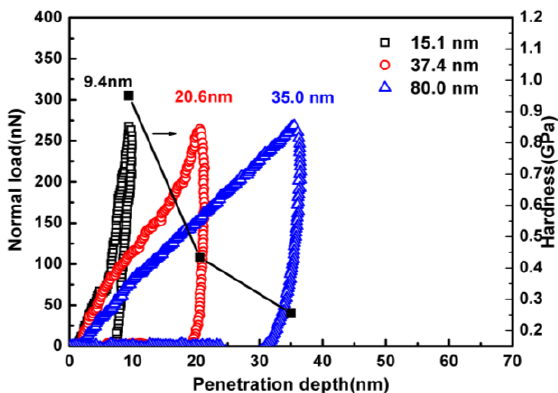
Figure 5. Force-penetration depth curve and hardness of PS thin film with different thickness on Si substrate obtained by nanoindentation.